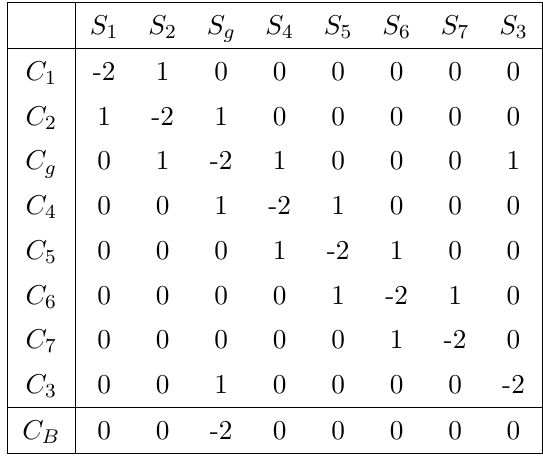
Table 6 . The matrix of the intersection numbers between the divisors S i ; i = 1 ; curves C i ; i = 1 ; ; 7 ; g; B . (cid:1) (cid:1) (cid:1) fugacity u of the pure E gauge theory is 8 E 8